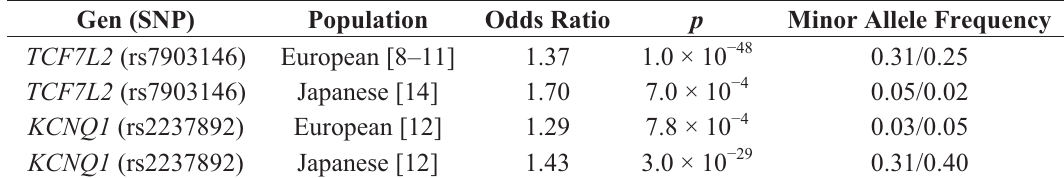
Table 1. Population differences of susceptibility genes to type II